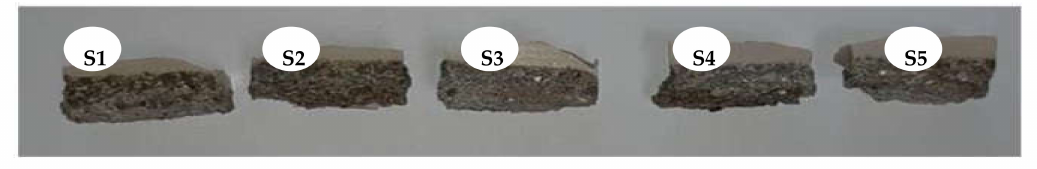
Figure 3. Cut samples from ornamental panel 1.